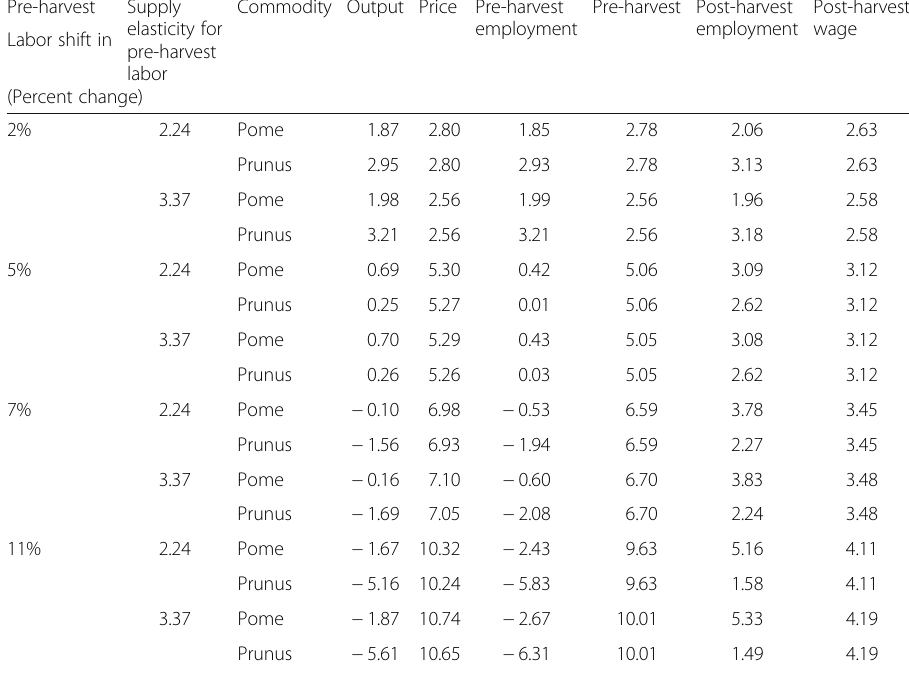
Table 11 Supply elasticity for pre- and post-harvest labor shock robustness results